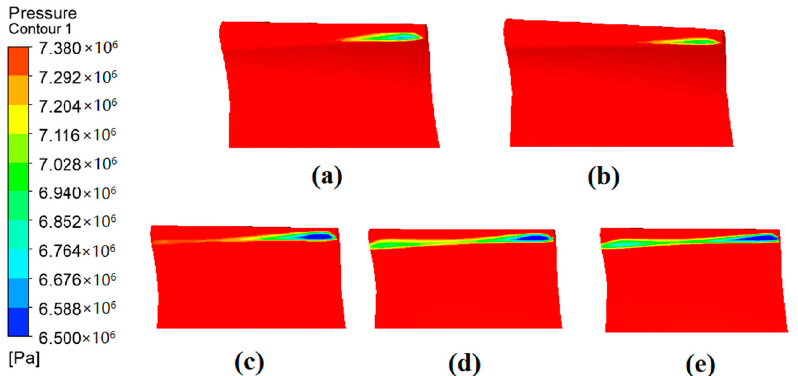
Figure 9. Trans-critical phenomenon at the trailing edge: ( a ) solidity 7.96; ( b ) solidity 9.95; ( c ) solidity 11.94; ( d ) solidity 13.93; ( e ) solidity 15.92.